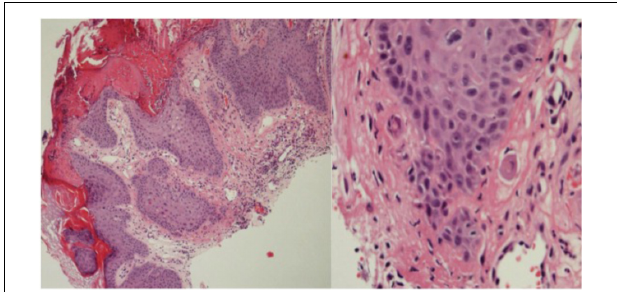
FIGURE 3 | Histology of lesion V4: Micro invasion in an SCC from patient 1 with features of viral infection in overlying and adjacent epidermis.